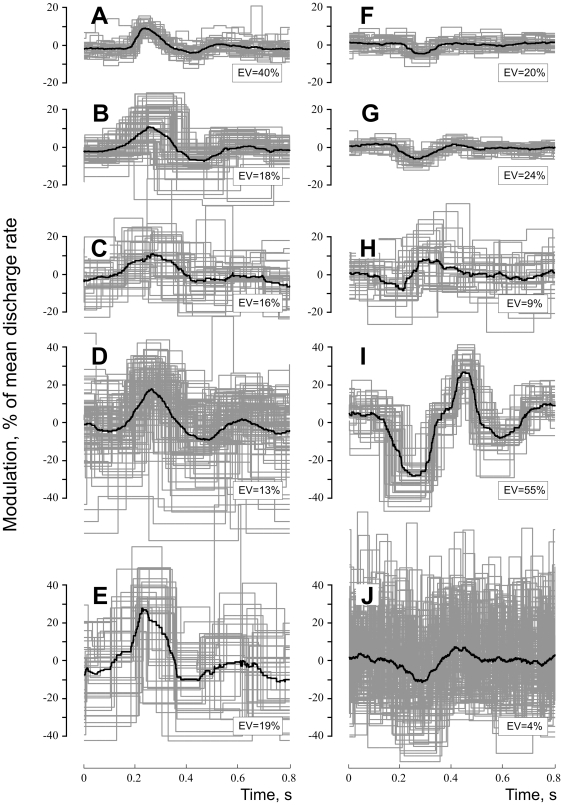
Examples of R-wave triggered discharge rate averages in pulse-wave modulated muscle spindles.Panels on the left (A–E) illustrate five afferents showing positive peak (excitatory response to the upbeat of pulse wave). Panels on the right (F–J) show five afferents displaying an initial negative peak (inhibitory effect). Discharge rate modulation is expressed as % difference from mean discharge rate. Time elapsed after R-wave is shown on the x-axis. Text box indicates the relative amount of variance explained by arterial pulsations (EV). Black thick lines represent averages. Gray thin lines show overlay of individual discharge rate traces in every cardiac cycle.